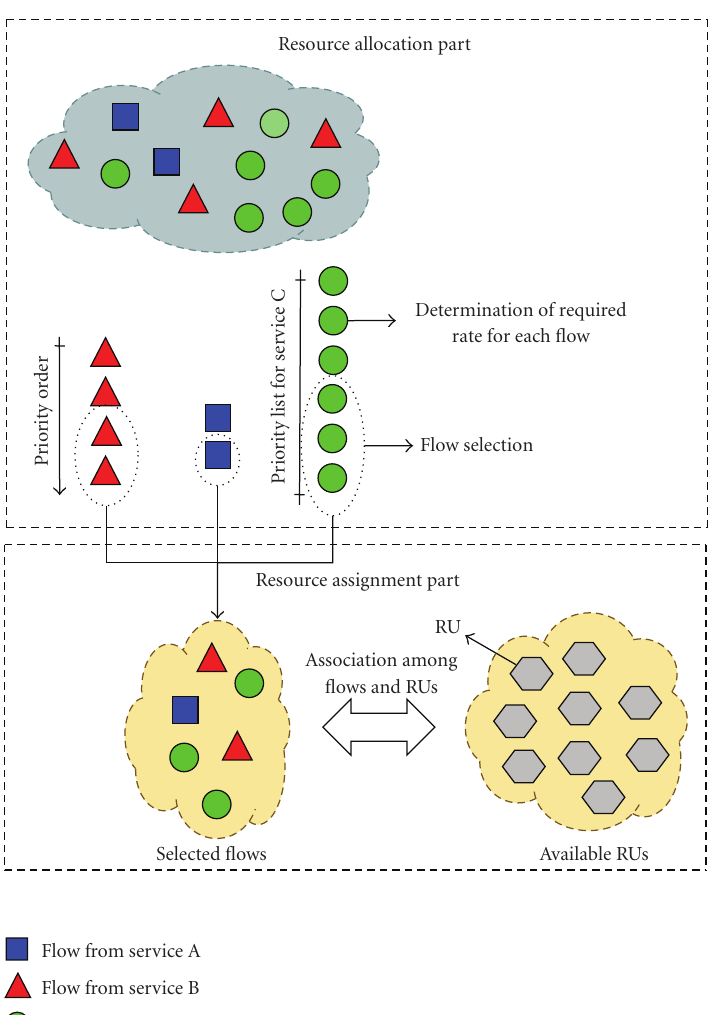
Figure 2: Building blocks of CRA. Illustration of the Resource Allocation and Resource Assignment parts.